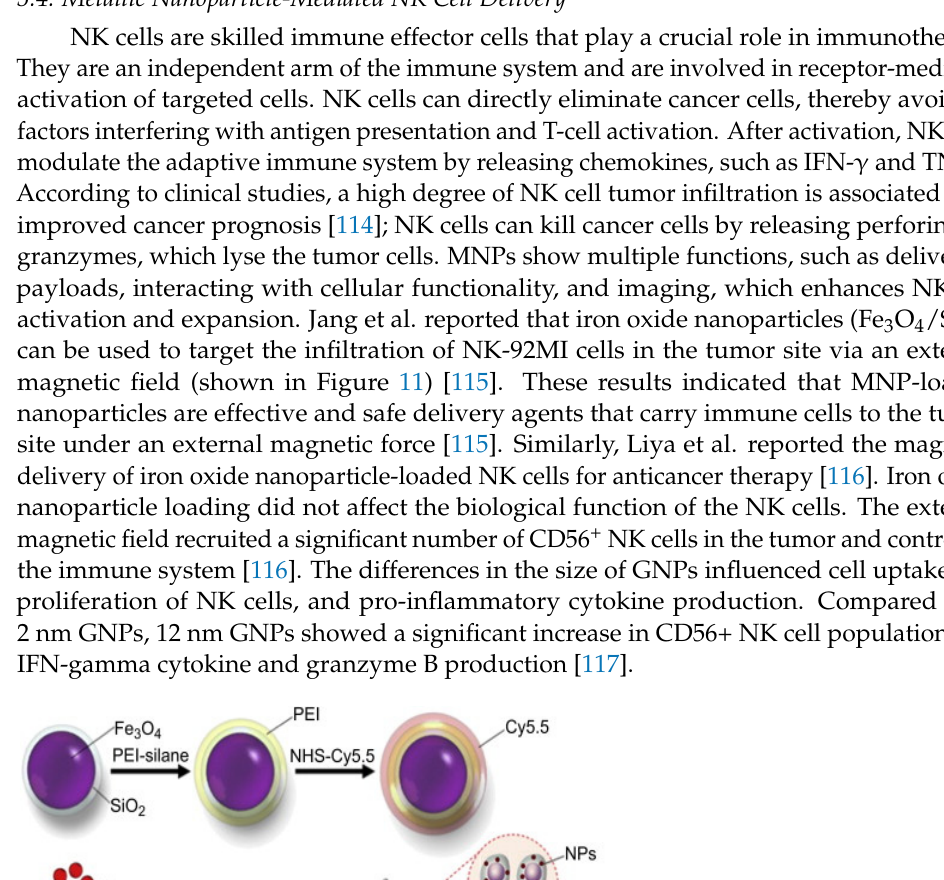
Figure 10. Schematic diagram of MNP-mediated macrophage polarization. The composition IONPs promote ratio (R) of intra cellular accumulation and elevateM0/M2 macrophage polarization to M1 and antitumor response. One-way anova was used for stastical analysis and results are displayed as mean ± SD, where **** p < 0.0001.